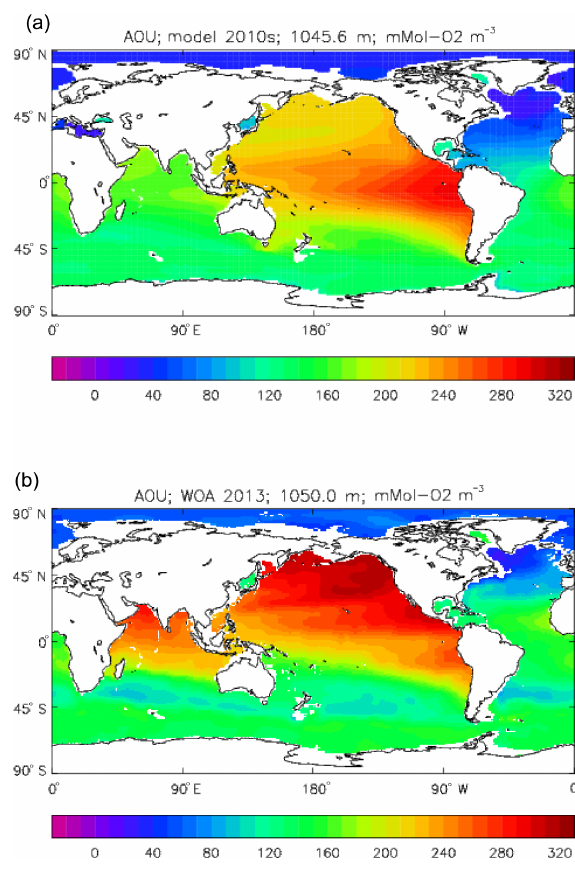
Figure 32. Apparent oxygen utilisation (mMolO 2 m − 3 ): (a) model field at 1045.6m, averaged over the years 2010 to 2019; (b) field at 1050m from the 2013 World Ocean